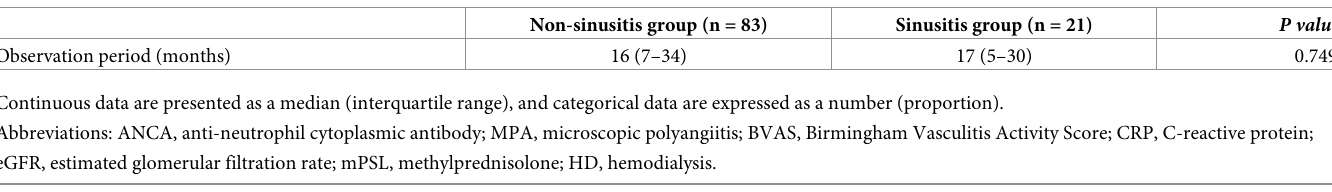
group: 73 [88.0%] patients) achieved remission (P = 0.332) (Table 1). After remission, 38 (40.9%) patients (sinusitis group: 13 [65.0%] patients; non-sinusitis group: 25 [34.3%] patients) relapsed at least once during the observational period (P = 0.013) (Table 1). No significant dif- ferences in the BVAS and organ involvement at relapse were found between the two groups (Table 1). At relapse, as well as at the time of MPA diagnosis, only three (12.0%) patients in the non-sinusitis group and two (15.4%) patients in the sinusitis group had been evaluated by sinus CT. Although no findings indicative of sinusitis were observed in the non-sinusitis group, two (100%) patients in the sinusitis group presented with CT findings of sinusitis asymptomatically, which had not changed significantly from the time of MPA diagnosis. Cumulative probabilities of the first relapse at 1, 2, and 5 years were 0.26, 0.59, and 0.80, respectively, in the sinusitis group and 0.13, 0.28, and 0.58, respectively, in the non-sinusitis group, suggesting that the incidence of the first relapse was significantly higher in the sinusitis group than in the non-sinusitis group (log-rank test: P = 0.020) (Fig 2).